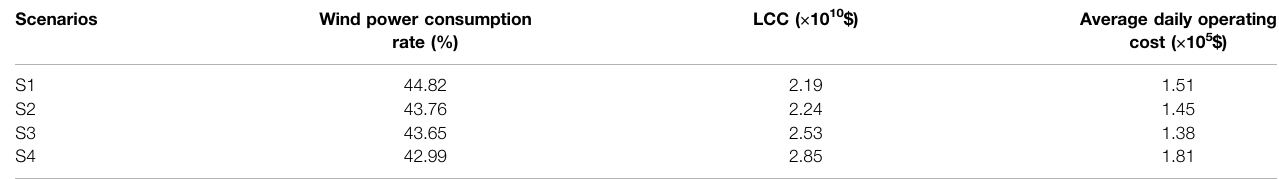
TABLE 6 | Comparison of planning results of different scenarios.